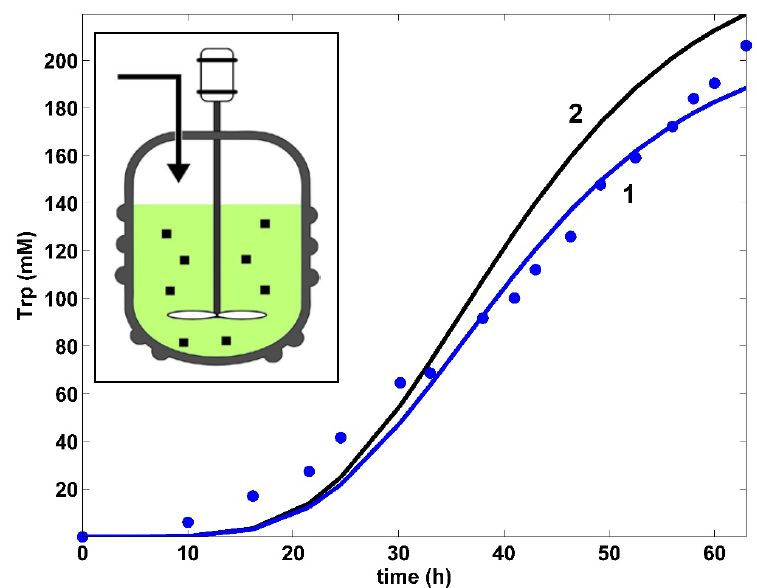
Figure 4. Model-based predictions of the tryptophan (Trp) concentration dynamics in the same FBR using the modified E. coli T5 strain, but operated in two alternatives: (i) (2, black) optimal operation derived in this paper (i.e., variable fed [GLC] and variable feed flow rate), or (ii) (1, blue) simulations [35] and the experimental data ( • , blue) of Chen [74] for the nominal, nonoptimal operation of Table 1, with a constant fed [GLC] and a constant feed flow rate. (Left corner) A simplified scheme of the used FBR with suspended biomass (small points).